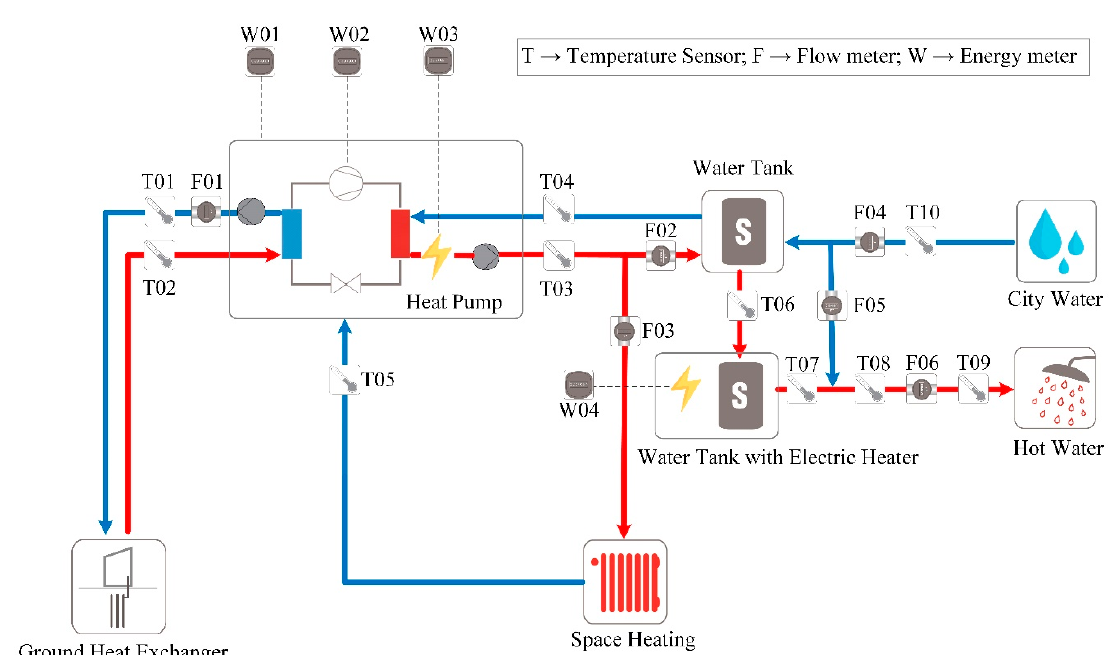
Figure 3. Floorplan of the clubhouse building.